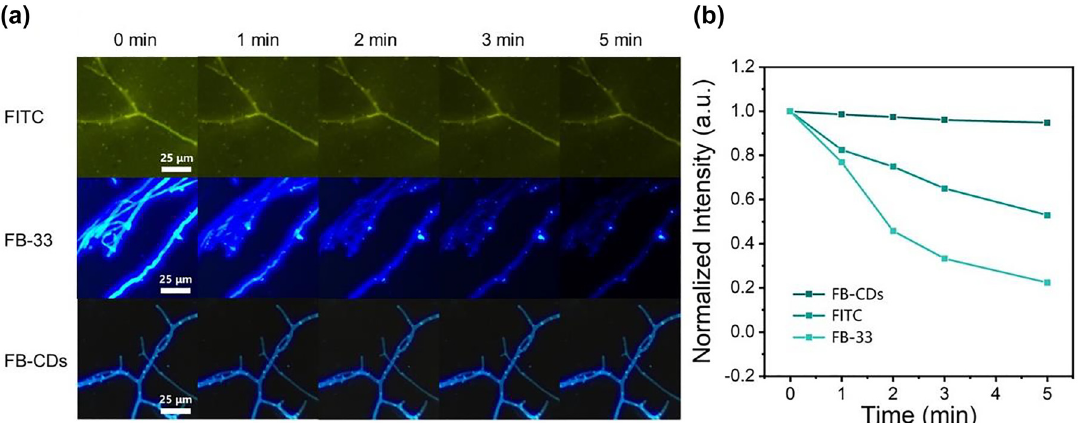
Figure 7: Photostability evaluation results of FB-CDs. (a) Fluorescence images of S. commune cells after being treated with FITC, FB-33, or FB-CDs captured every 1 min. (b) Corresponding fluorescence quenching curves calculated from the fungal